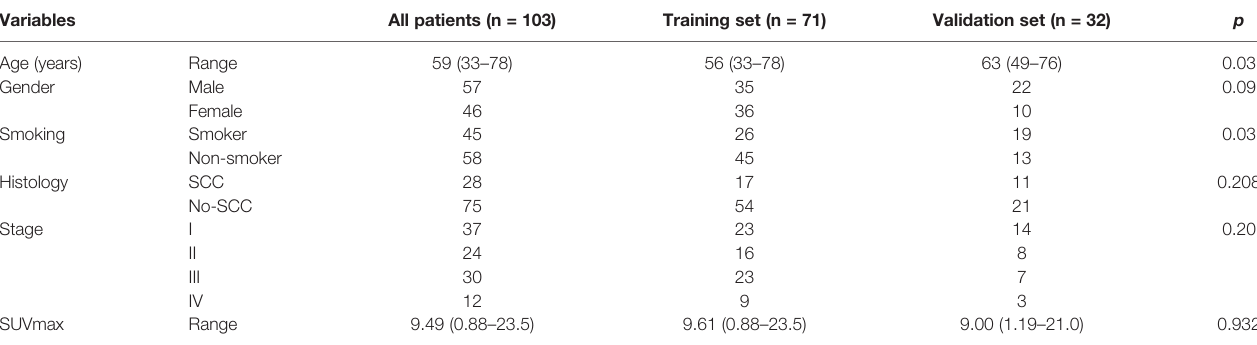
TABLE 1 | Demographic and clinical data of all